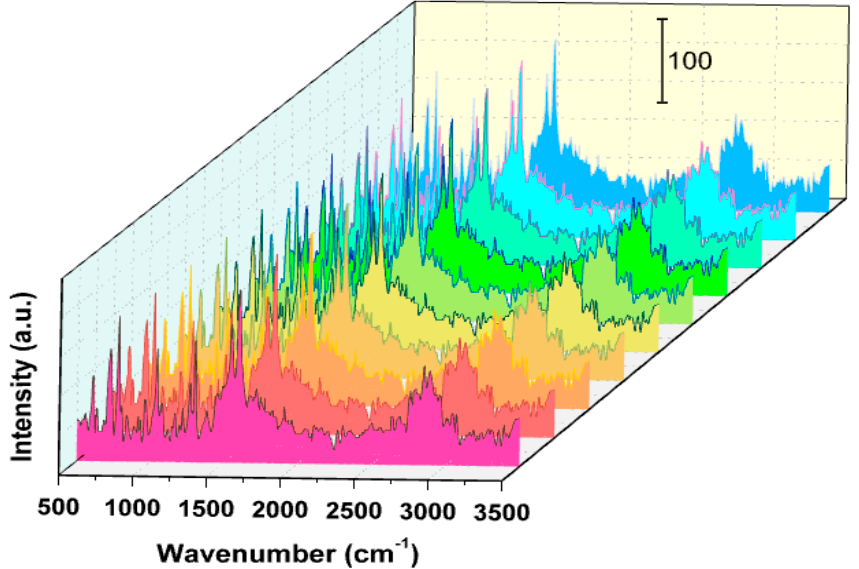
Figure 8. Raman spectra of 5 mg/L of thiophanate methyl obtained at 10 random locations on AuNR-coated glass substrate.